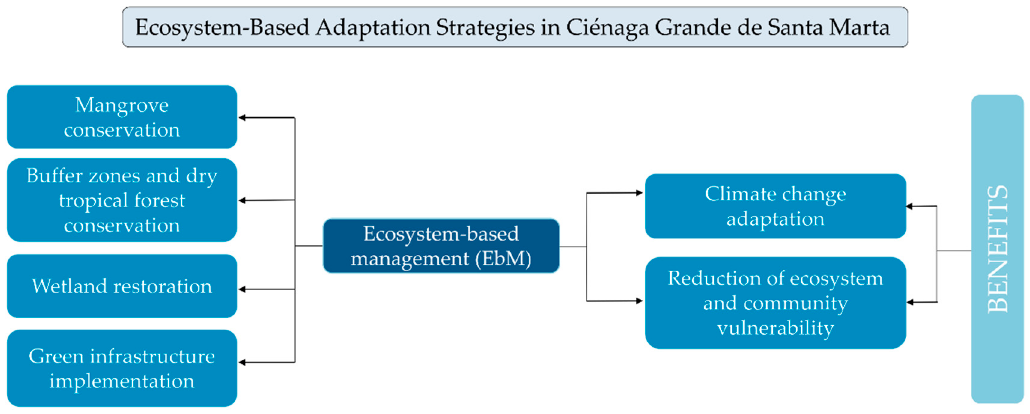
Figure 12. Ecosystem-Based Management (EbM) Strategies for CGSM.